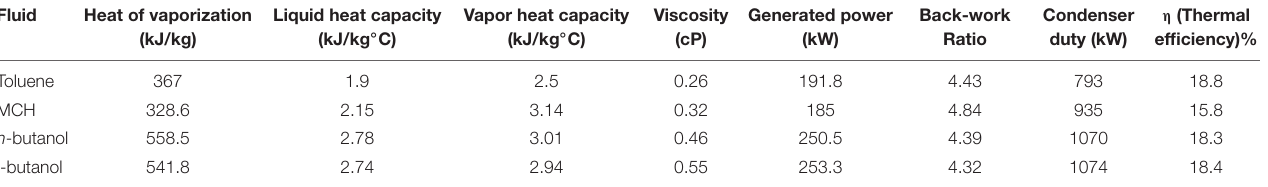
TABLE 3 | Comparison of thermodynamic parameters of toluene, methylcyclohexane, n -butanol, and i -butanol. Fluid Heat of vaporization